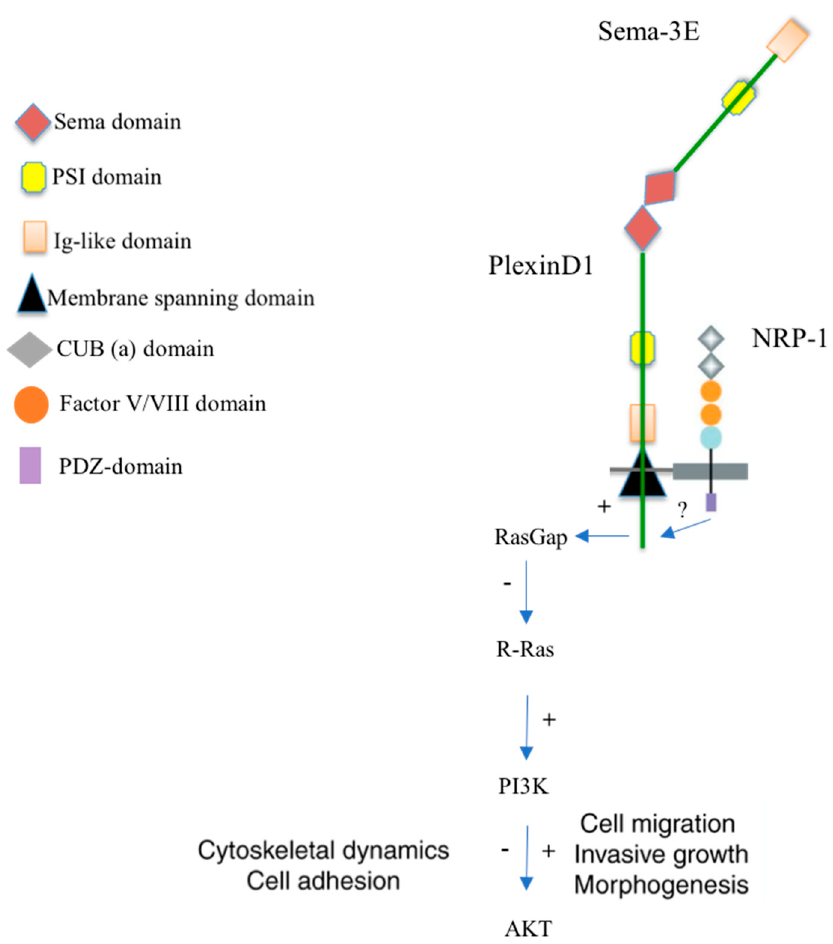
Figure 2. The Sema-3E/Plexin-D1 receptor signaling. Sema3E binds its receptor, Plexin-D1. This interaction leads to the activation of the intracellular Plexin-D1 RasGAP (Ras GTPase